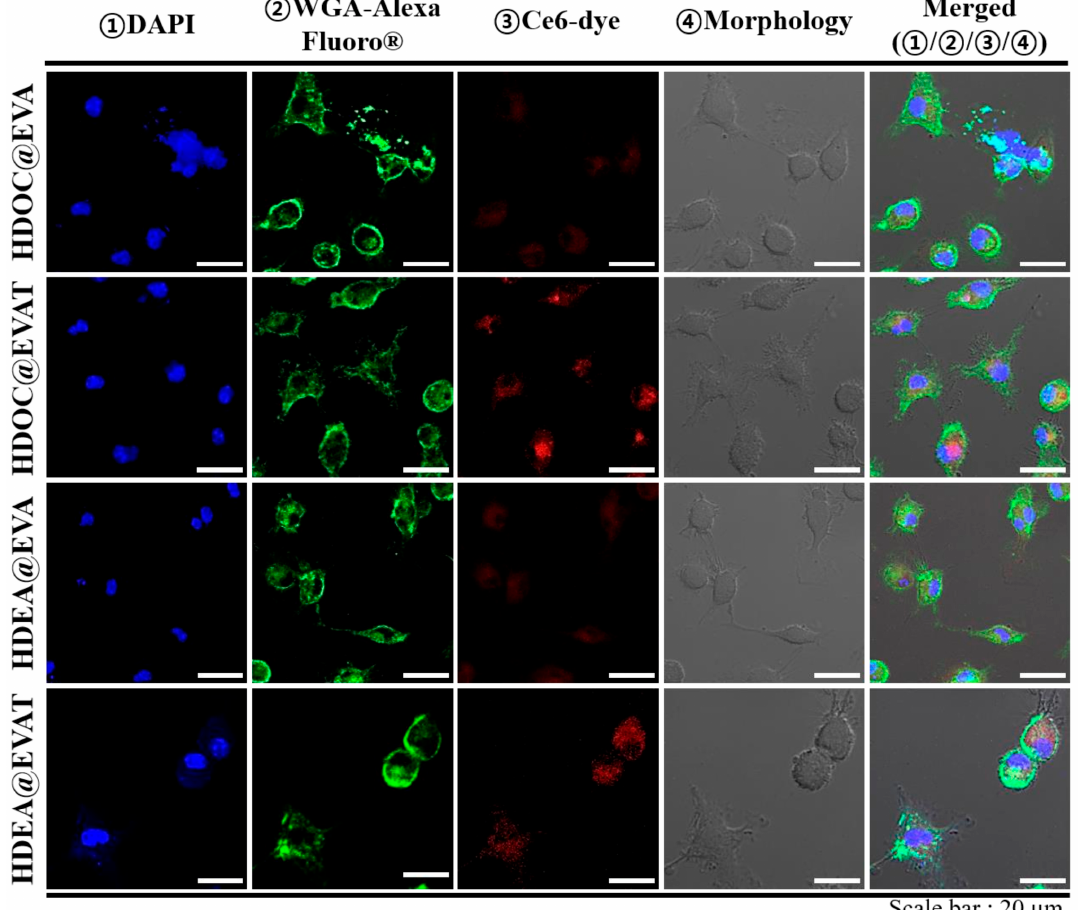
Figure 5. Confocal images of DCs treated with fluorescent Ce6 ‐ labeled EVs after incubation for 4 h at 37 ◦ C.